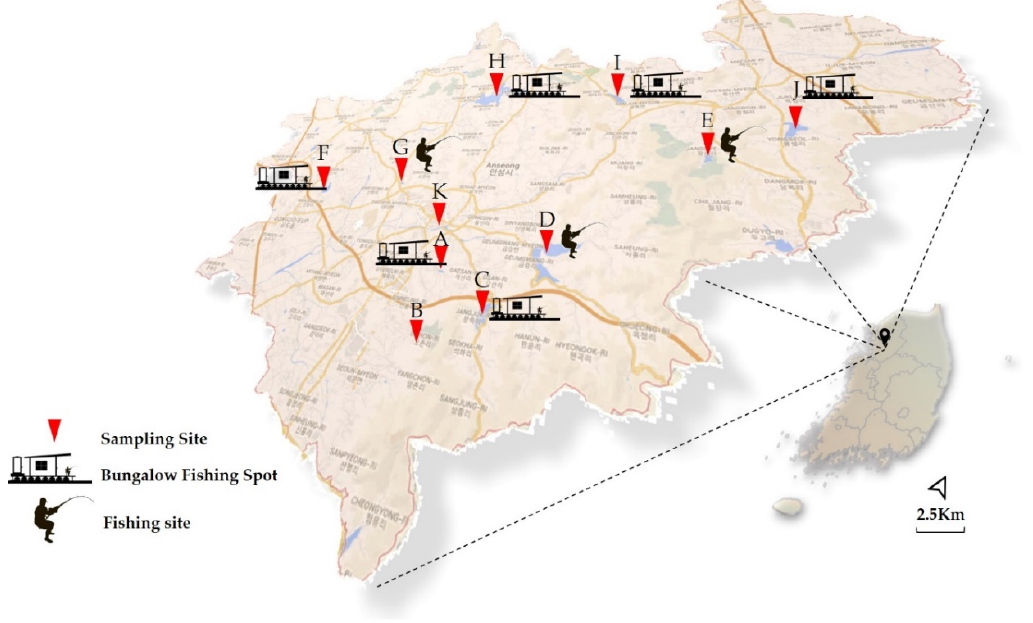
Figure 1. Geographical locations of ten reservoirs and Anseong River (site K) in Gyeonggi province, South Korea. Site K is characterized by the downstream merging of sites C and D. Fishing sites and bungalow fishing spots represent recreational facilities.